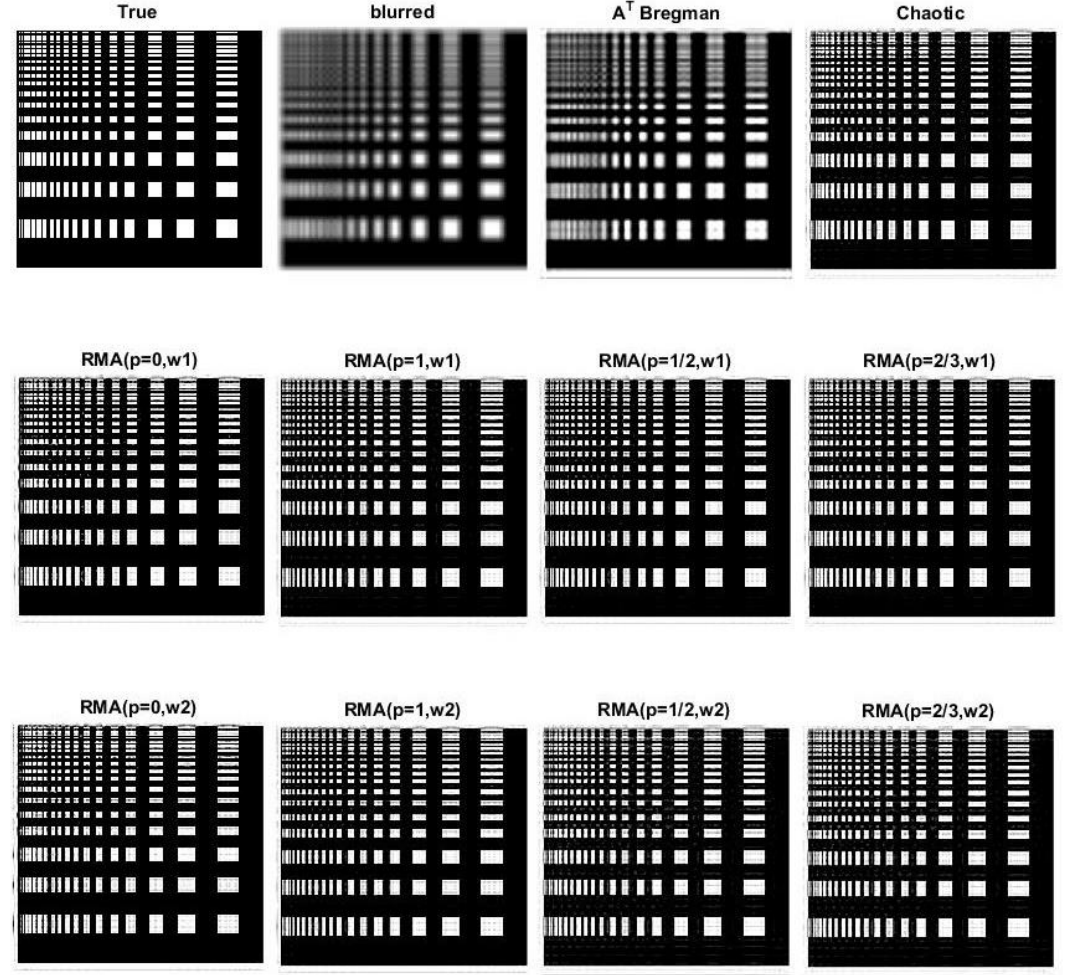
Figure 4. Deblurring results of the A T Bregman iteration, Chaotic iteration, and RMA with ω 1 , ω 2 , when p = 0,1,1/2,2/3 for a 256 × 256 image convolved by a 5 × 5 disk kernel. Table 3. The comparison of Figure 3 deblurring results.